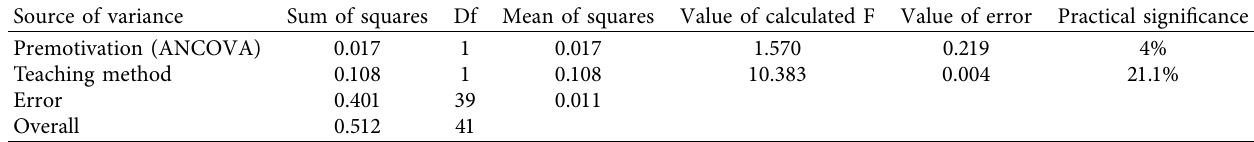
Table 5: Results of the one-way ANCOVA analysis of variance.